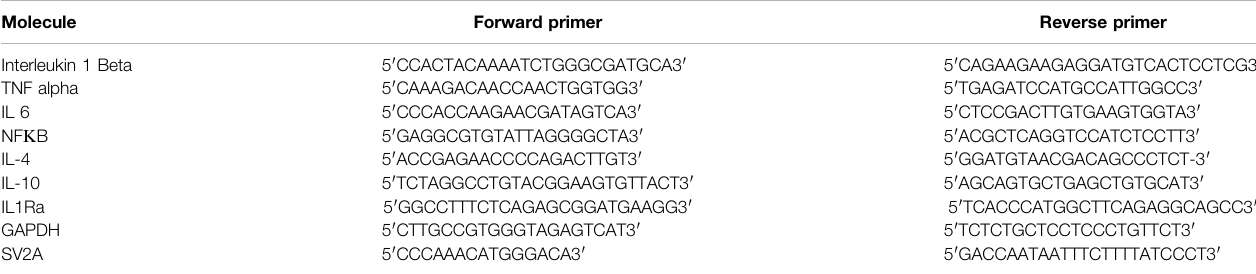
TABLE 1 | Forward and reverse primers are